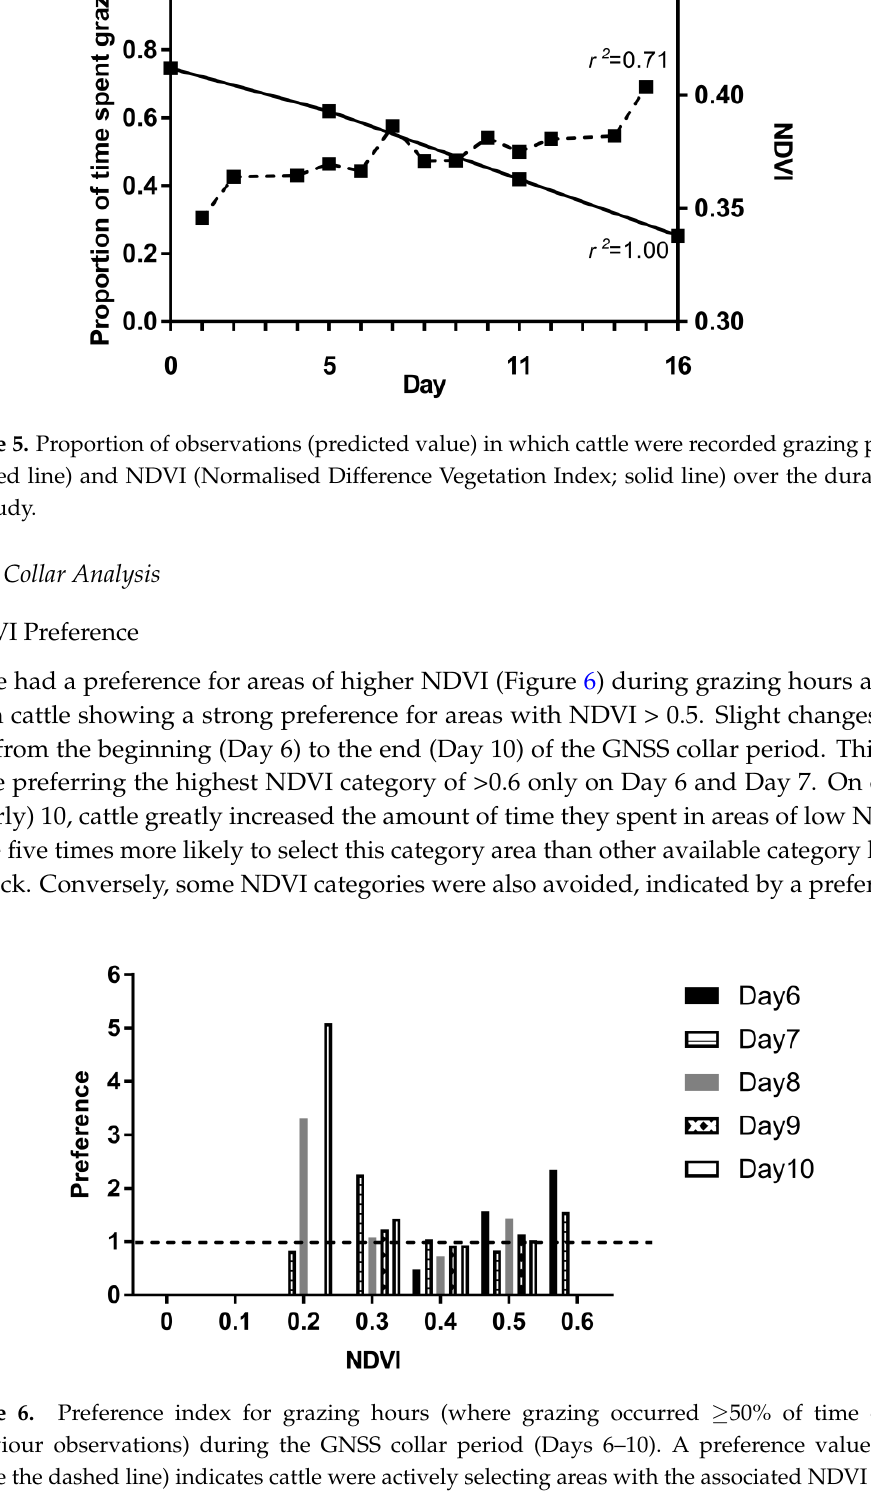
Figure 4. Proportion of time spent undertaking each of the six most commonly recorded behaviours each day during daylight hours over the duration of the study. Observations were not recorded on Days 3 and 13.